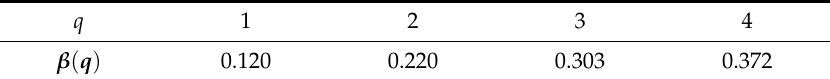
Table 1. Transaction cost information